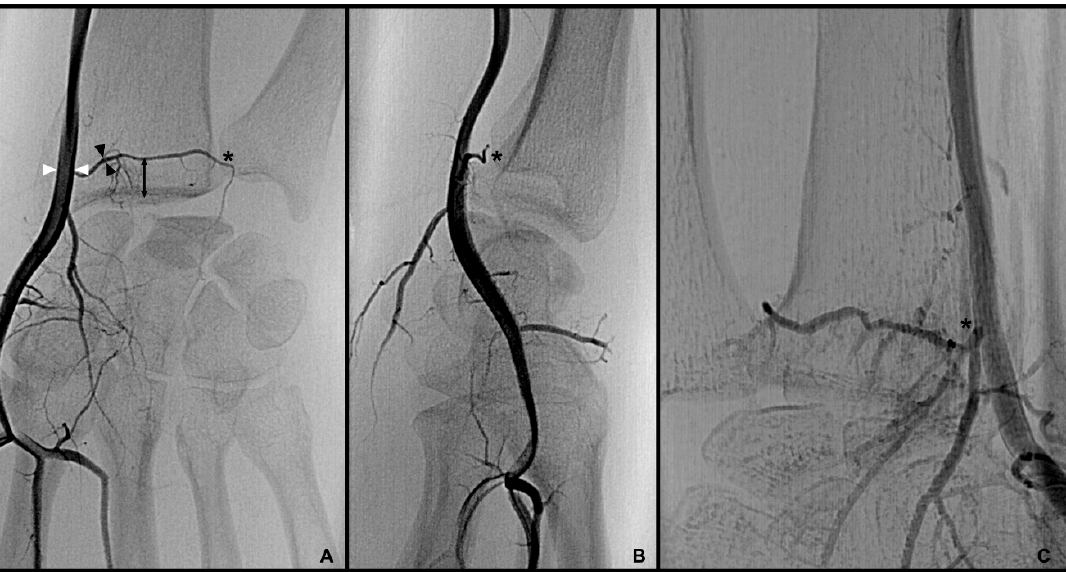
Figure 2. ( A ): Palmo-dorsal superselective angiography of the radial artery with the PRCA arising from one main branch. ( B ): Lateral projection of the radial artery to verify the palmar location of the vessel. ( C ). Palmo-dorsal superselective angiography of the radial artery with the PRCA arising as part of a ramification. * PRCA, (cid:78) maximum diameter of the PRCA, (cid:52) diameter of the radial artery at the point of ramification, ←→ distance from the PRCA to the midface of the radiocarpal joint (PRCA = palmar radiocarpal arch).